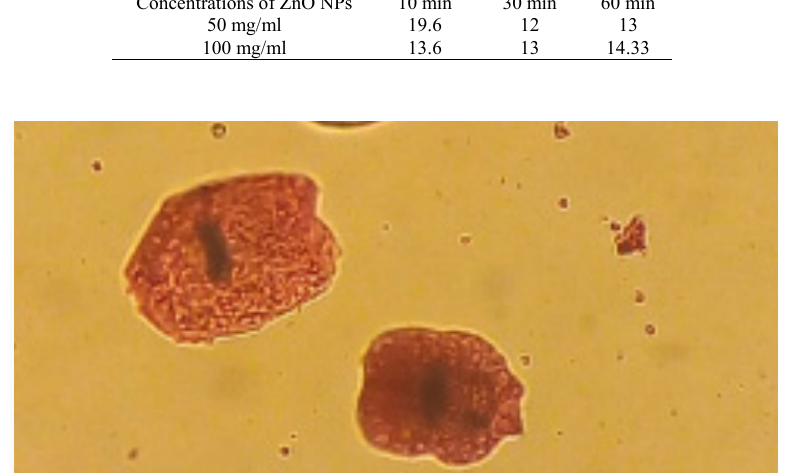
Fig. 3. Image of dead protoscolices